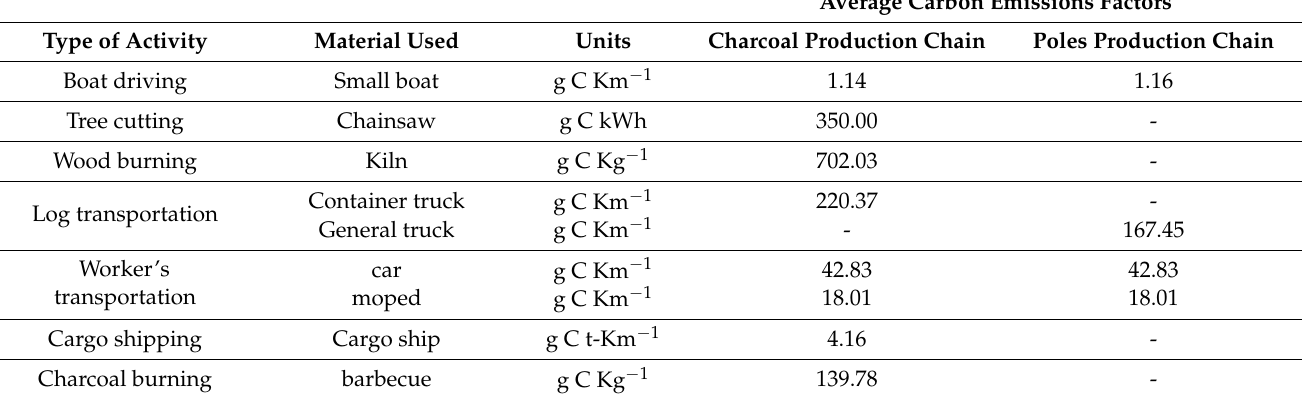
Table 3. Average carbon emission factors per each activity in the two production chains (charcoal and poles). These values were calculated considering the brands and models of the equipment used, number of workers, and mean distances